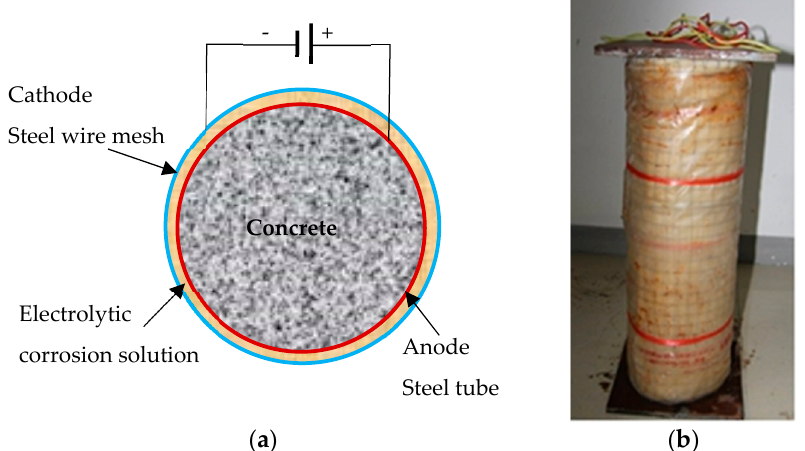
Figure 2. Schematic and photograph of accelerated corrosion on a CFST column. ( a ) The schematic; ( b ) a photograph.